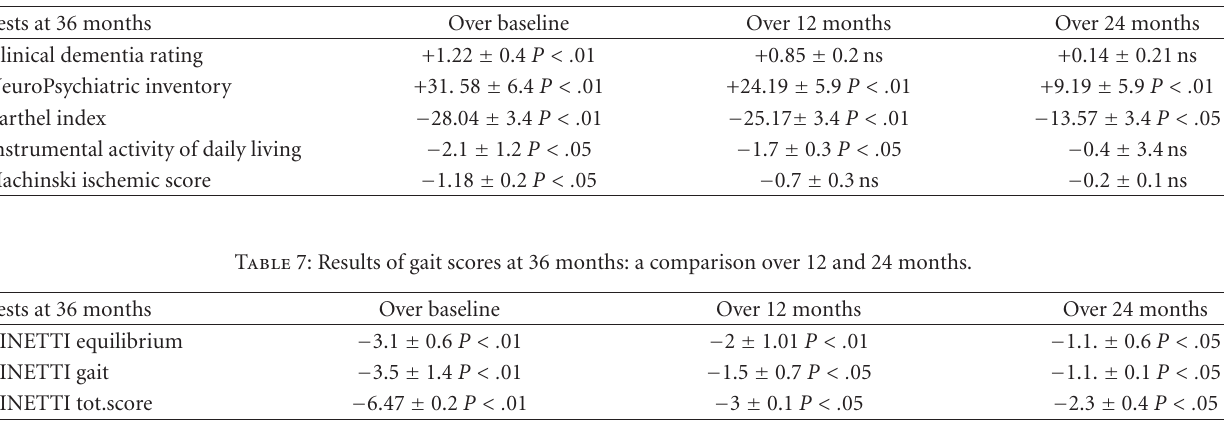
Table 6: Results at 36 months: a comparison over 12 and 24 months.